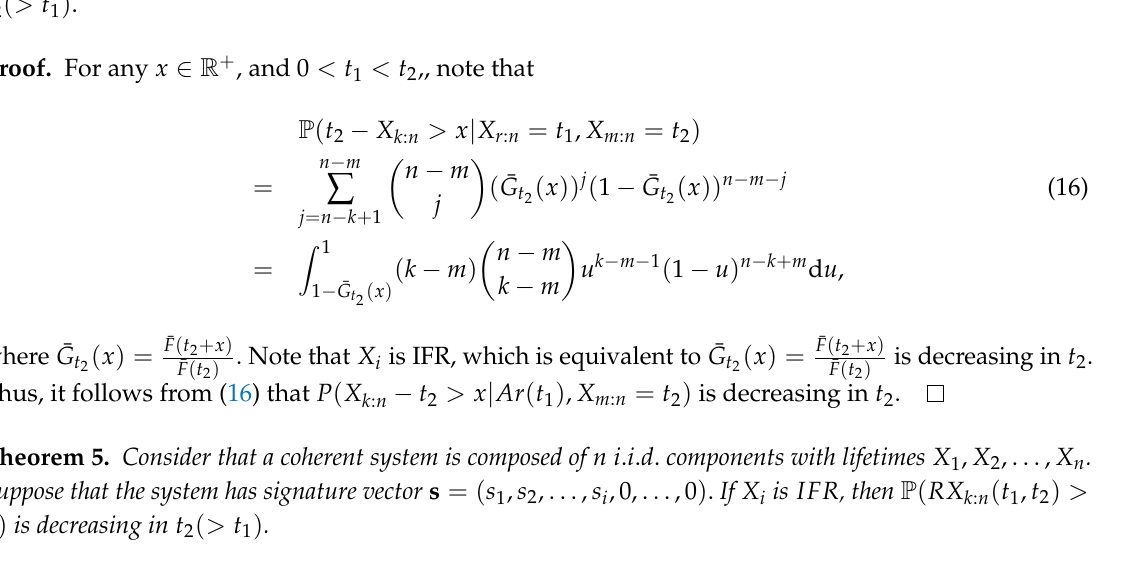
; x )) / ( f ( RX T 1 ; x )) , for the t 1 = 1 ( left ) and t 2 = 8 ( right 4:4 4:4